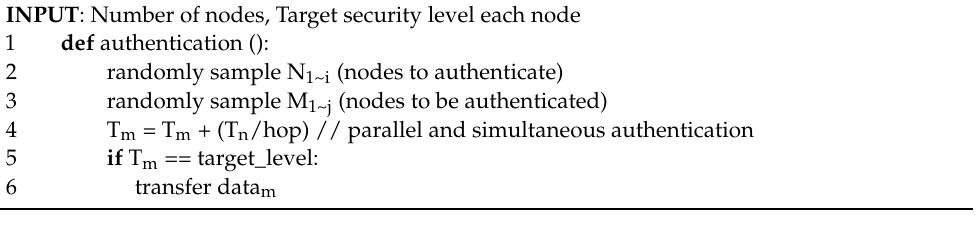
Algorithm 2. Pseudo code for DAM4SNC authentication function